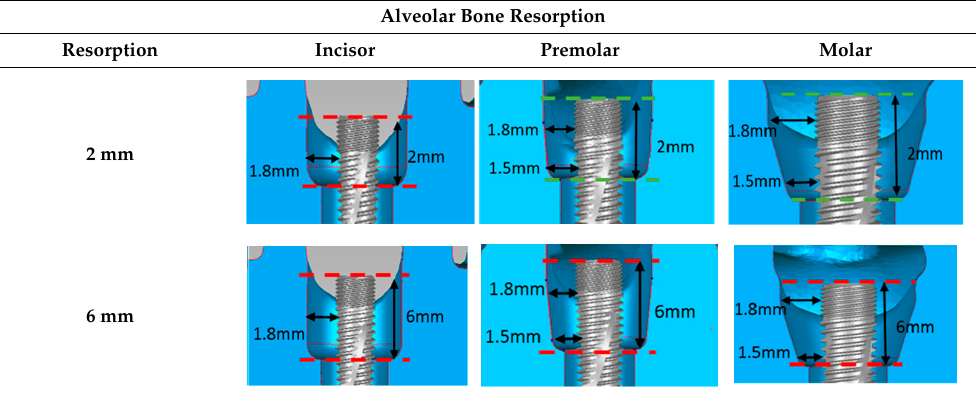
Figure 1. Peri-implantitis model design. ( a ) Computer-aided design (CAD) model of peri-implantitis scanned from a digital jaw model. ( b ) Shallow and deep peri-implant intra-bony defects designed with 2 mm and 6 mm depth. ( c ) Acrylonitrile butadiene styrene (ABS) 3D-printed model with peri-implantitis at mandibular incisor, premolar, and molar positions. Table 1. Design of two types of modeling of peri-implantitis with alveolar bone resorption.